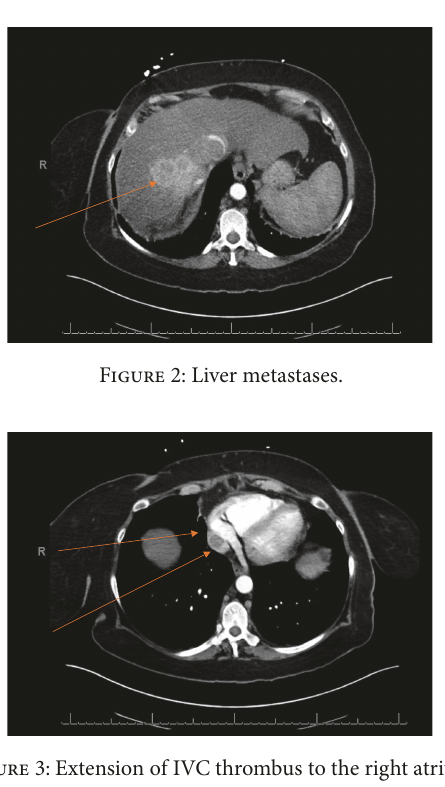
Figure 1: Right renal tumor with IVC thrombus.